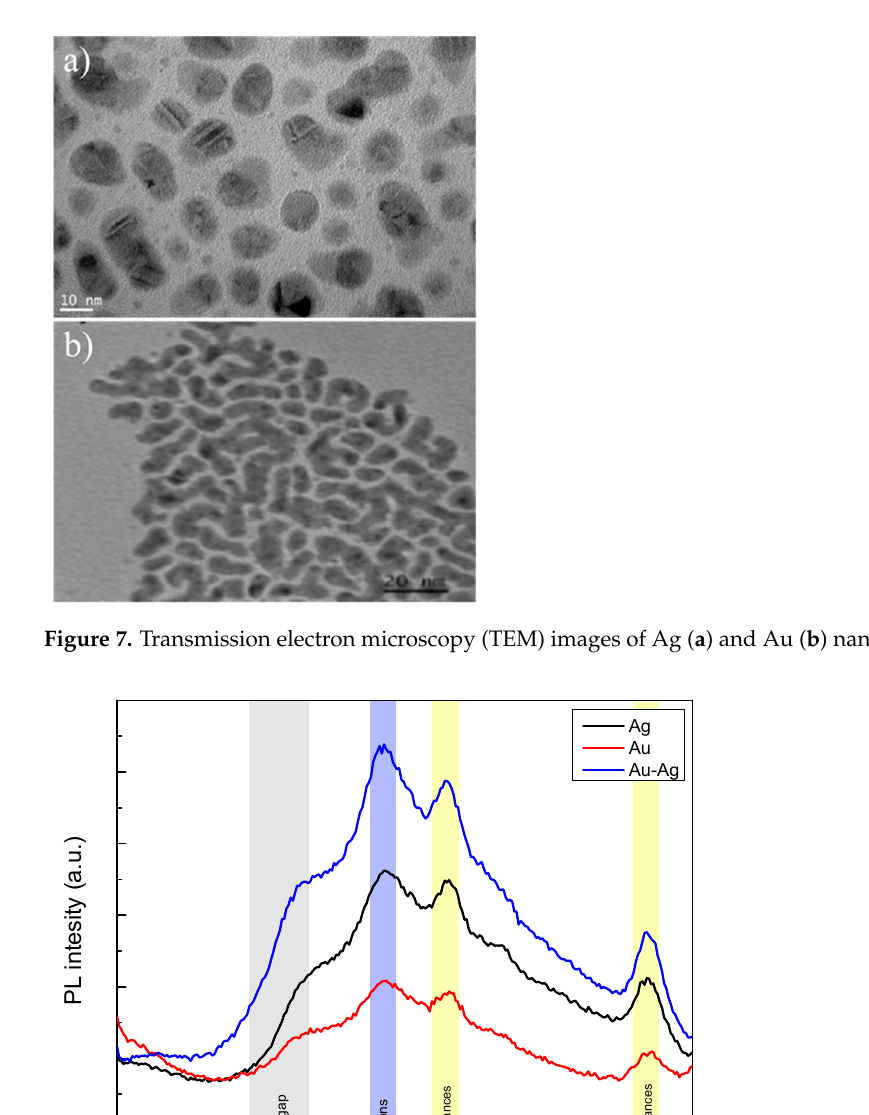
Figure 8. Photoluminescence spectra of TiO 2 films with Ag, Au, and Au-Ag nanoparticles.